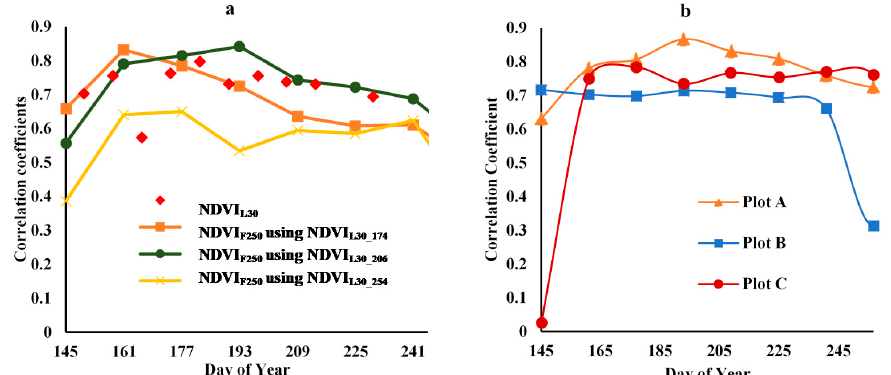
Figure 16. Correlation coefficients between NDVI L30 , NDVI F250 fused with 3 dates of Landsat (DOY174, 206, 254) and cotton yield ( a ) correlation coefficient results from NDVI F250 for three plots; ( b ) correlation coefficient results from MOD13Q1 and Landsat NDVI L30_206 of three plots.